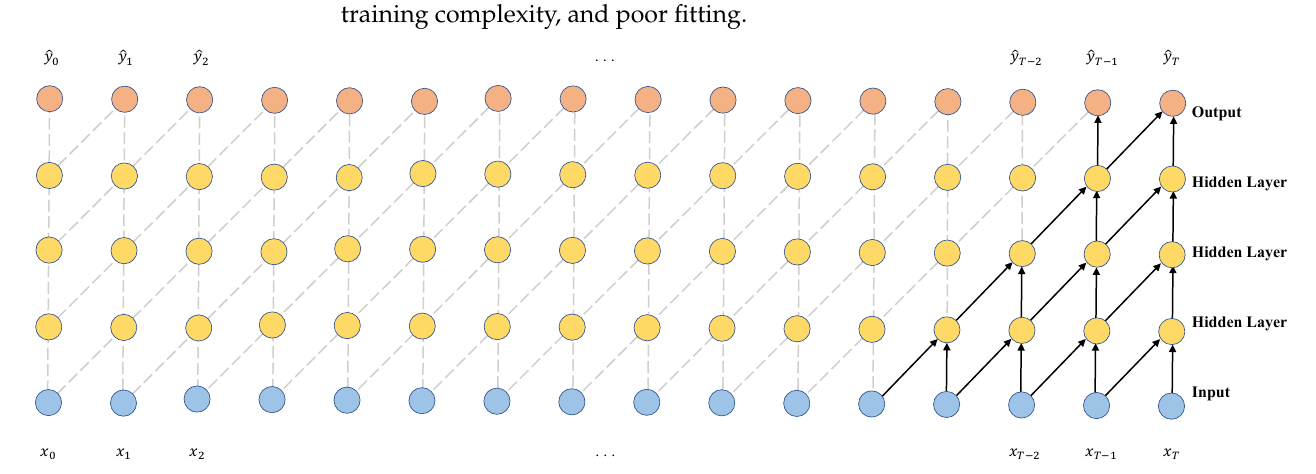
Figure 3. Visualization of a stack of causal convolutional layers.